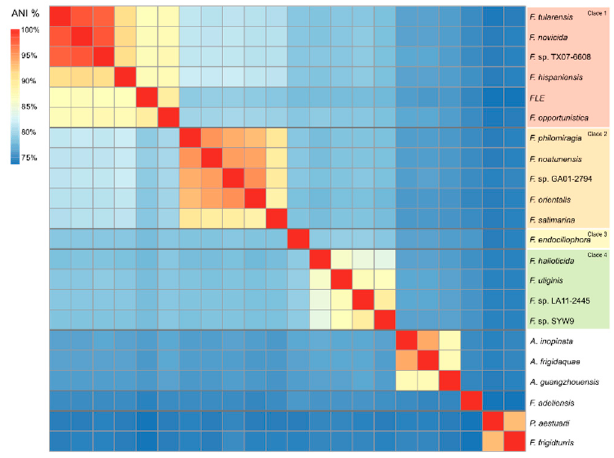
Figure 2. Clustered heatmap visualizing ANI values between Francisella , Allofrancisella , Parafrancisella , and Pseudofrancisella species.